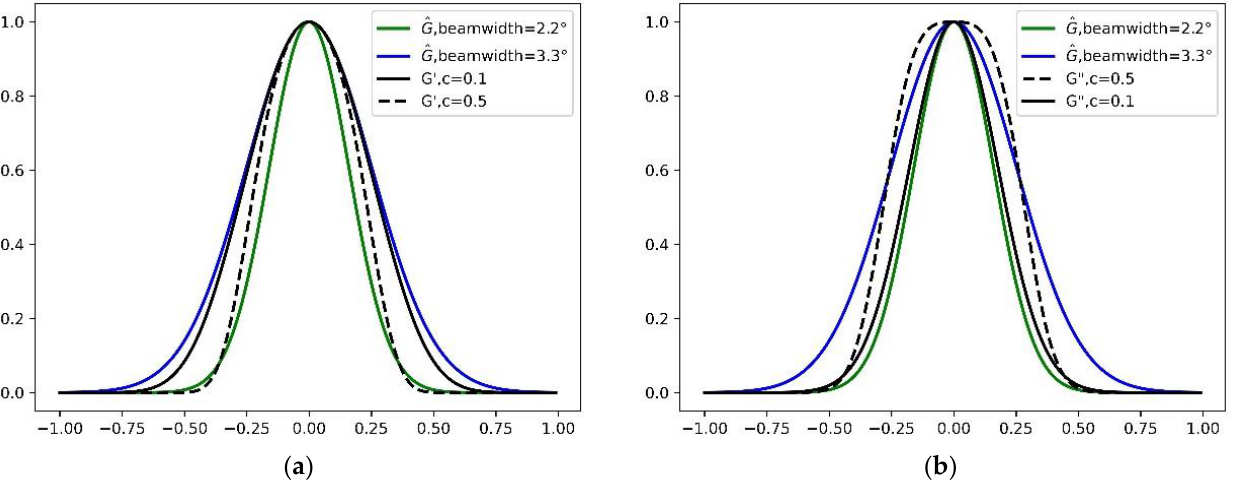
Figure 3. Adjusted antenna beams in the frequency domain ( a ) using the original AAPP resampling algorithm and ( b ) using a modified AAPP resampling algorithm.